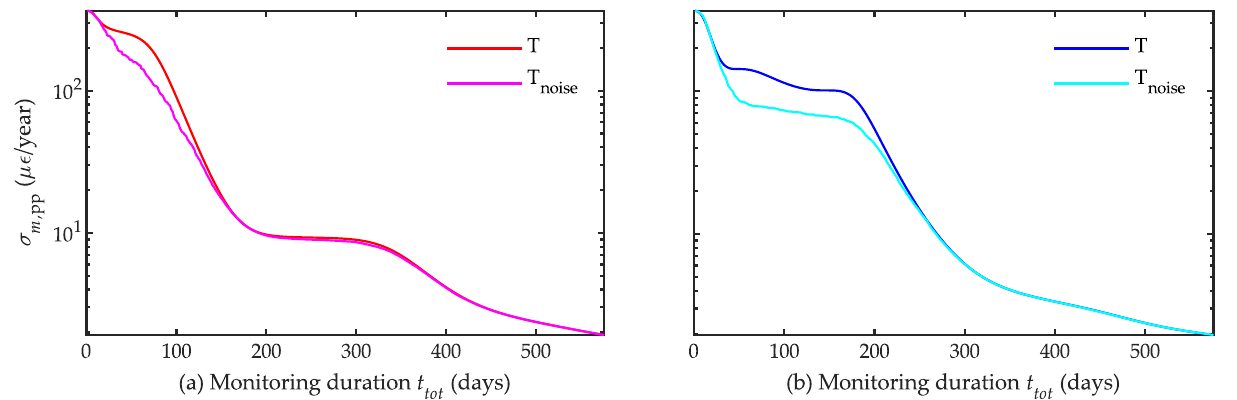
Figure 7. Expected uncertainty σ m ,pp of the linear-trend parameter m estimated in the design phase. Phase parameter b is set as ( a ) b = 0 and ( b ) b = π /2. The monitoring duration t tot varies from 3 to 600 days.